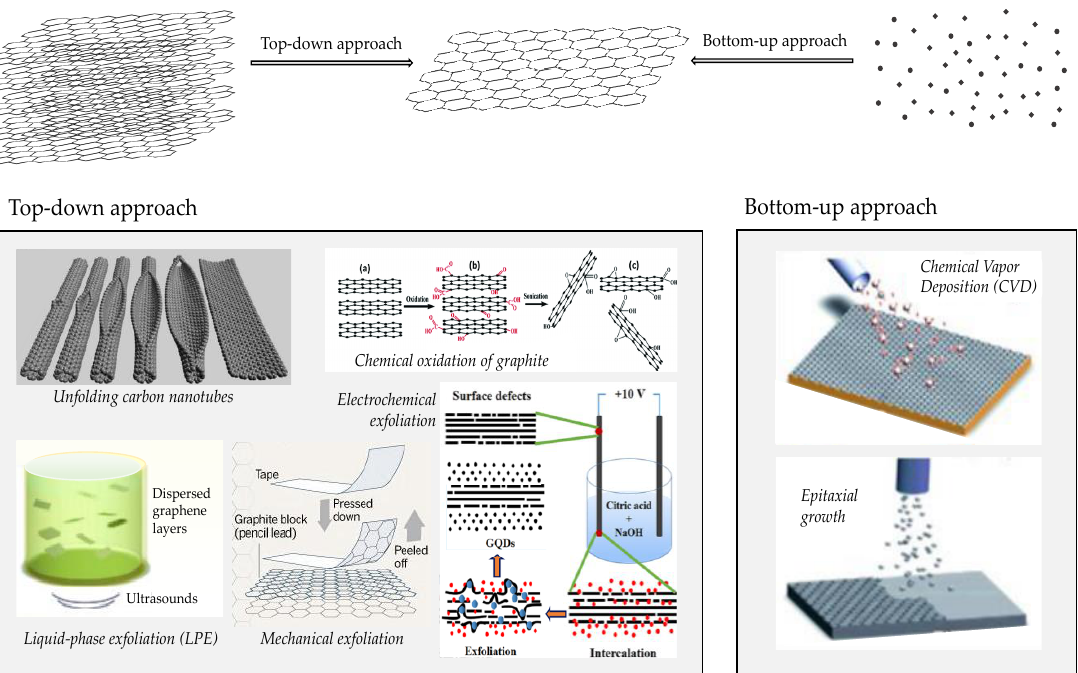
Bottom-up approach